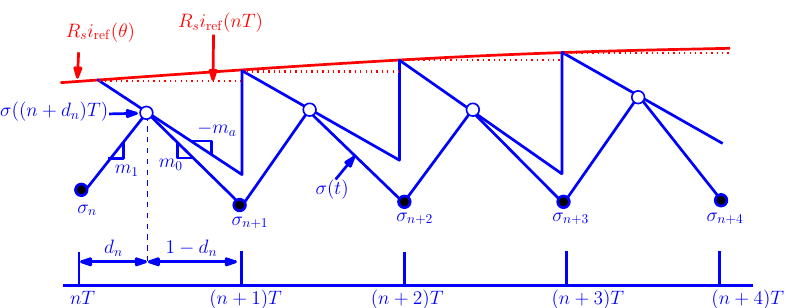
Figure 8. The feedback signal σ and the control signal R s ref ( θ )